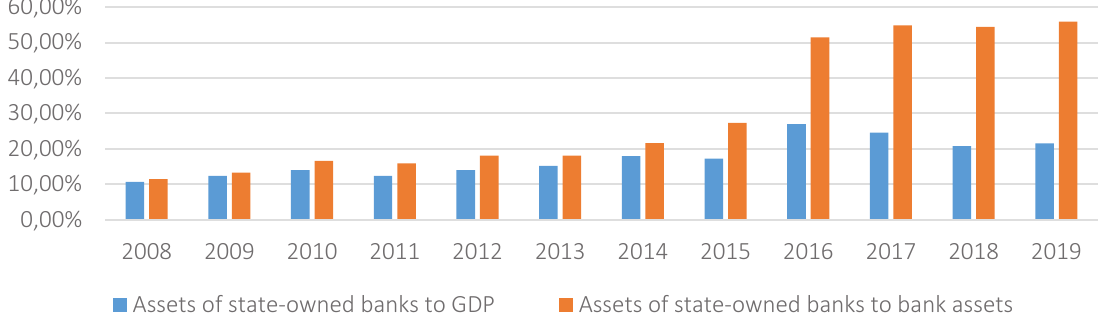
Figure 11. Indicators of the asset structure of Ukrainian banks